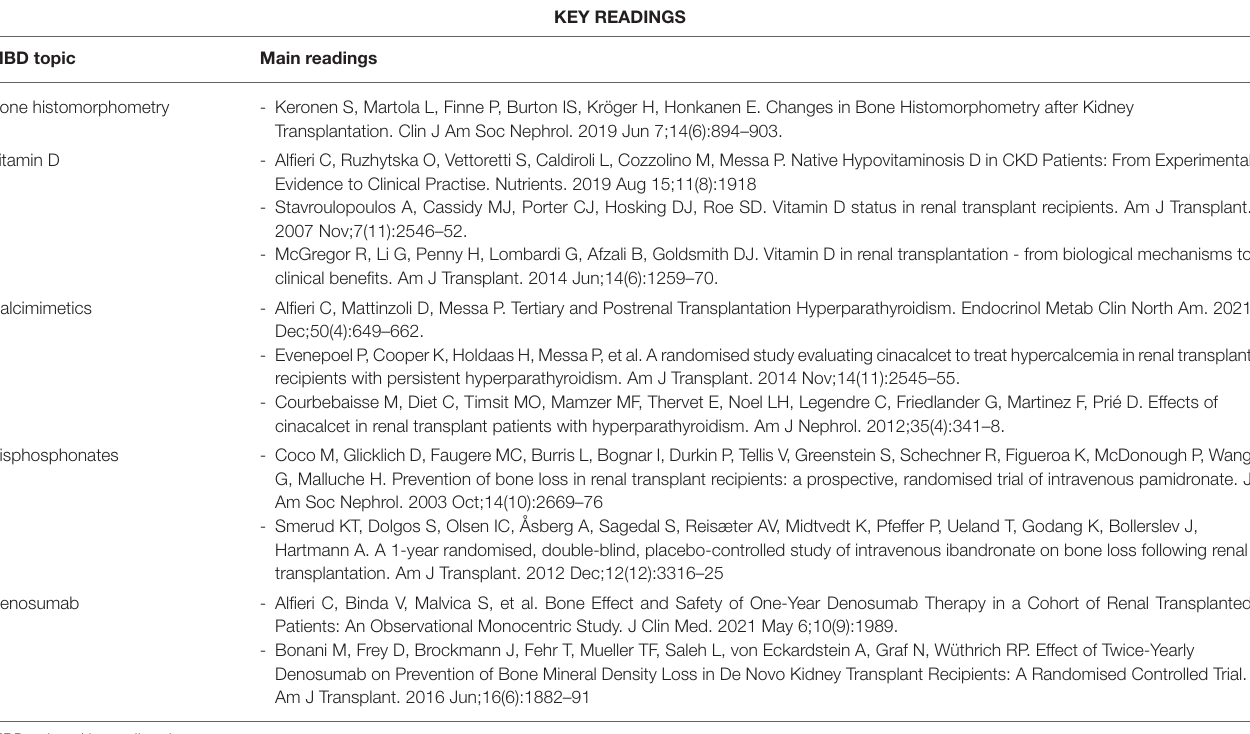
TABLE 2 | Key readings concerning post-RTx-MBD.